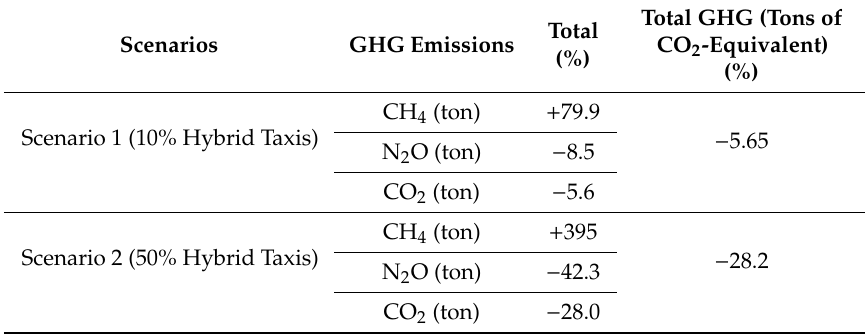
Table 5. Results summary for di ff erent scenarios compared to scenario 0 (0% Hybrid),